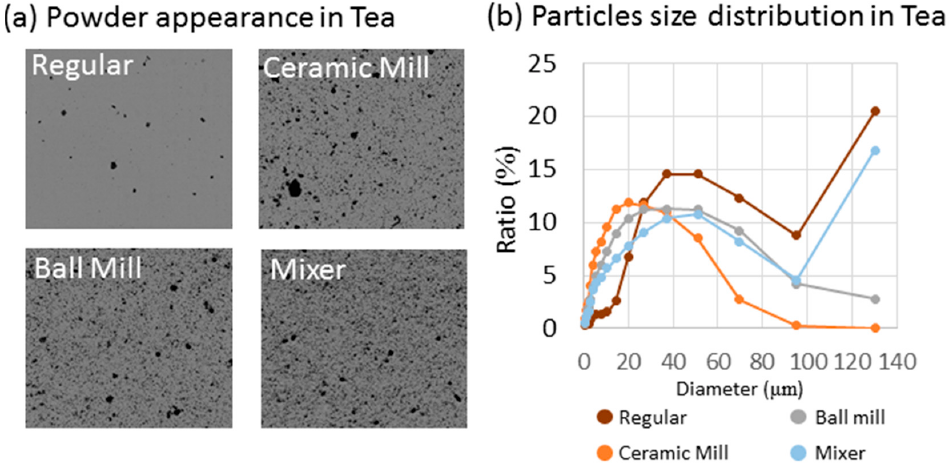
Figure 2. Particle appearance in the green tea liquid and size distribution of tea particles: ( a ) multifocal microscope images of particles in regular tea and the powdered tea produced by indicated powdering process; and ( b ) particle size distributions of the teas measured with laser diffraction particle size analyzer. Regular: Regular leaf tea.